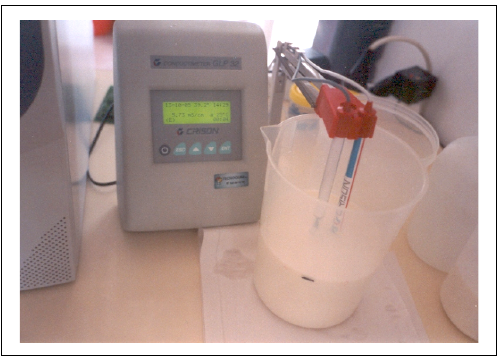
Figure 2. Reference conductimeter. Laboratory EC